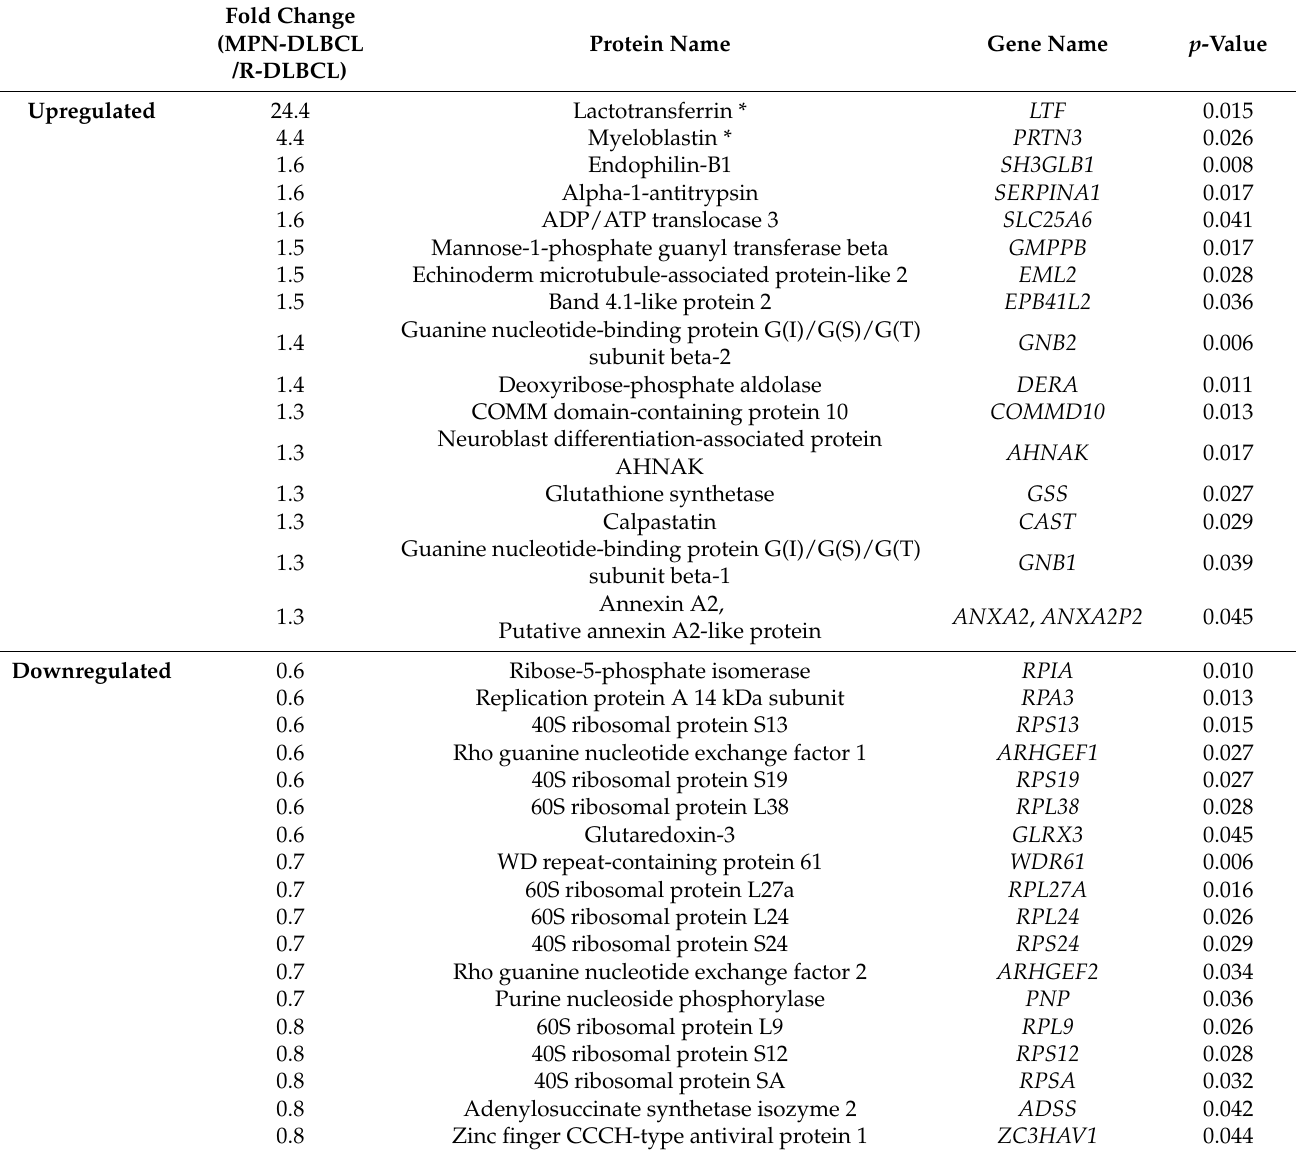
Table 3. Differentially expressed proteins between MPN-DLBCL and R-DLBCL